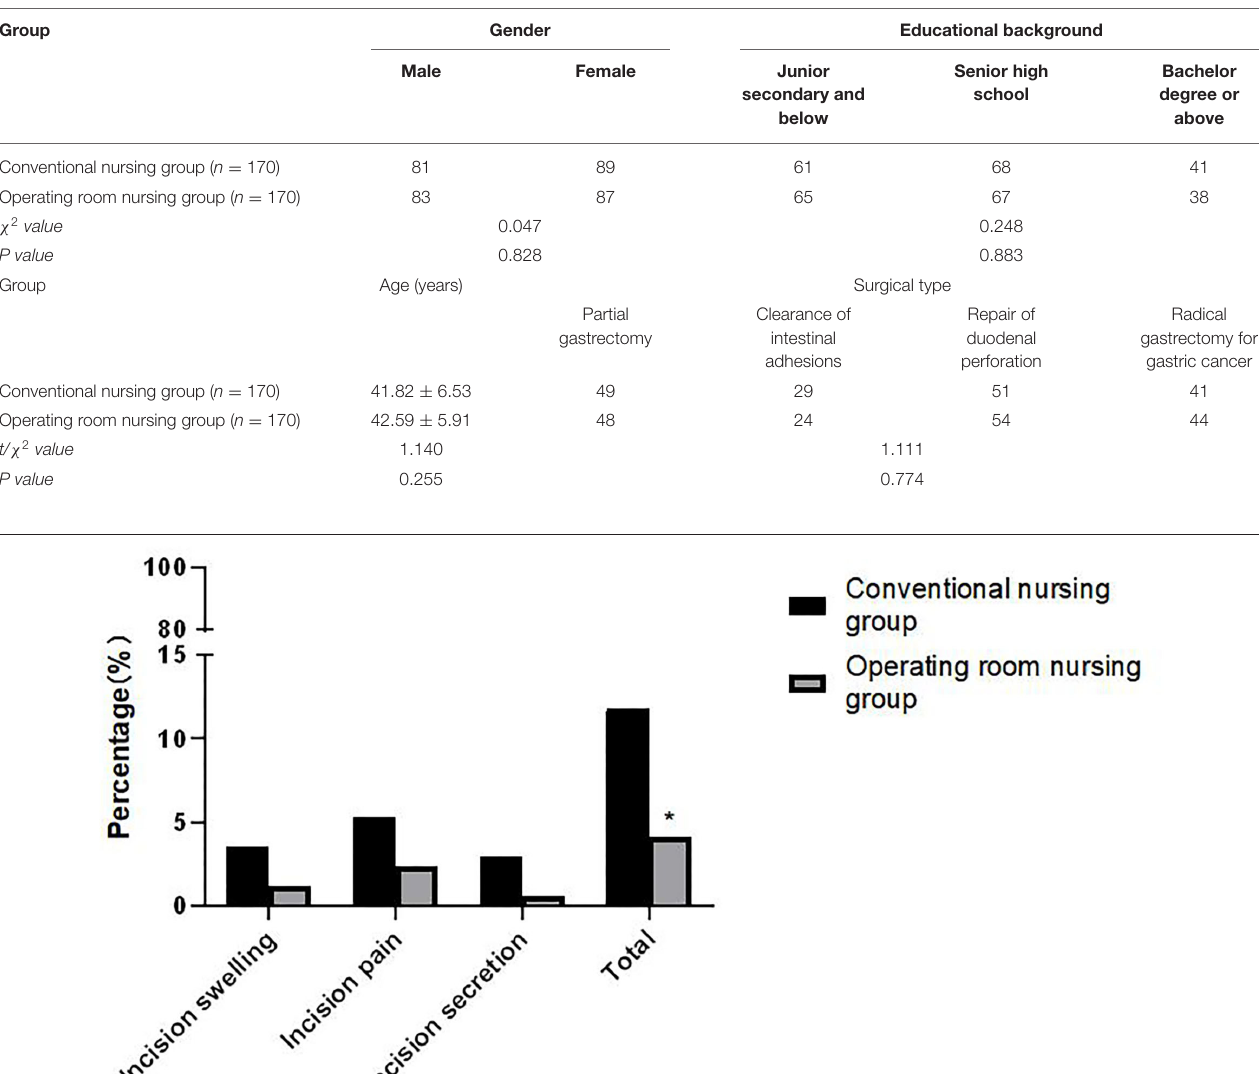
TABLE 1 | Comparison of general data of patients between the two groups. Group Gender Educational background